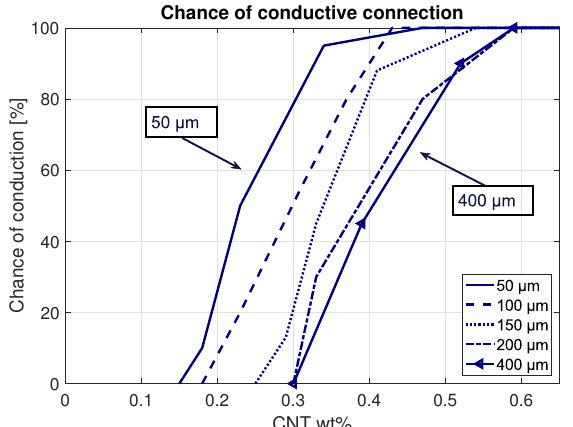
Figure 7. Statistical chance of formed conductive networks between electrodes with different sen- sor